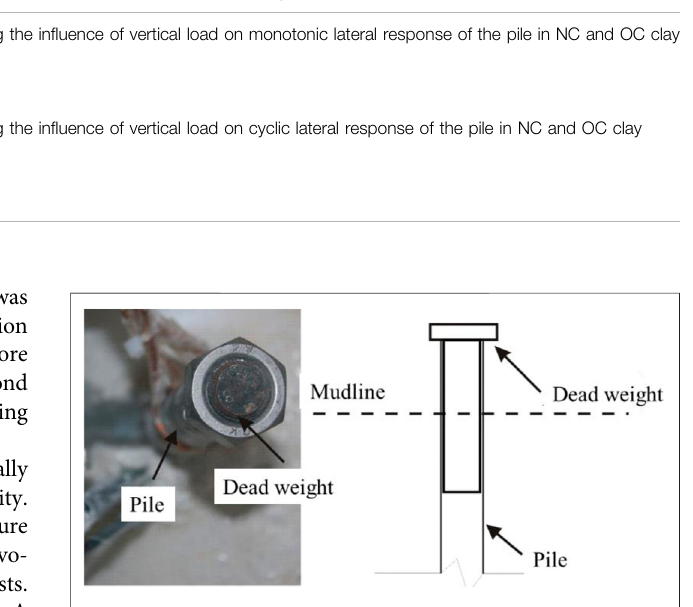
FIGURE 1 | Application method of vertical